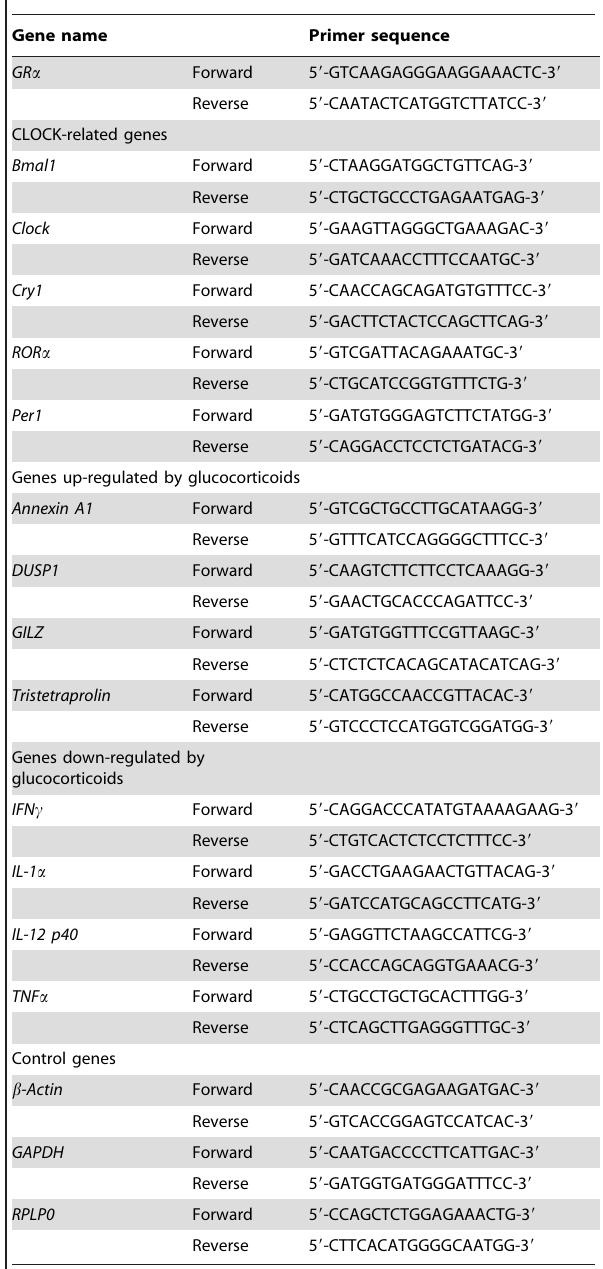
Bmal1: brain-muscle-arnt-like protein 1, Clock: circadian locomotor output cycle kaput, Cry1: Cryptochrome 1 , DUSP1: dual specificity phosphatase 1, GAPDH: glyceraldehyde-3-phosphate dehydrogenase, GILZ: glucocorticoid-responsive leucine zipper protein, GR a : glucocorticoid receptor a , IFN c : interferon c , IL-1 a : interleukin-1 a , Per1: period 1, ROR a : retinoic acid receptor-related orphan receptor a , RPLP0: ribosomal protein large P0.